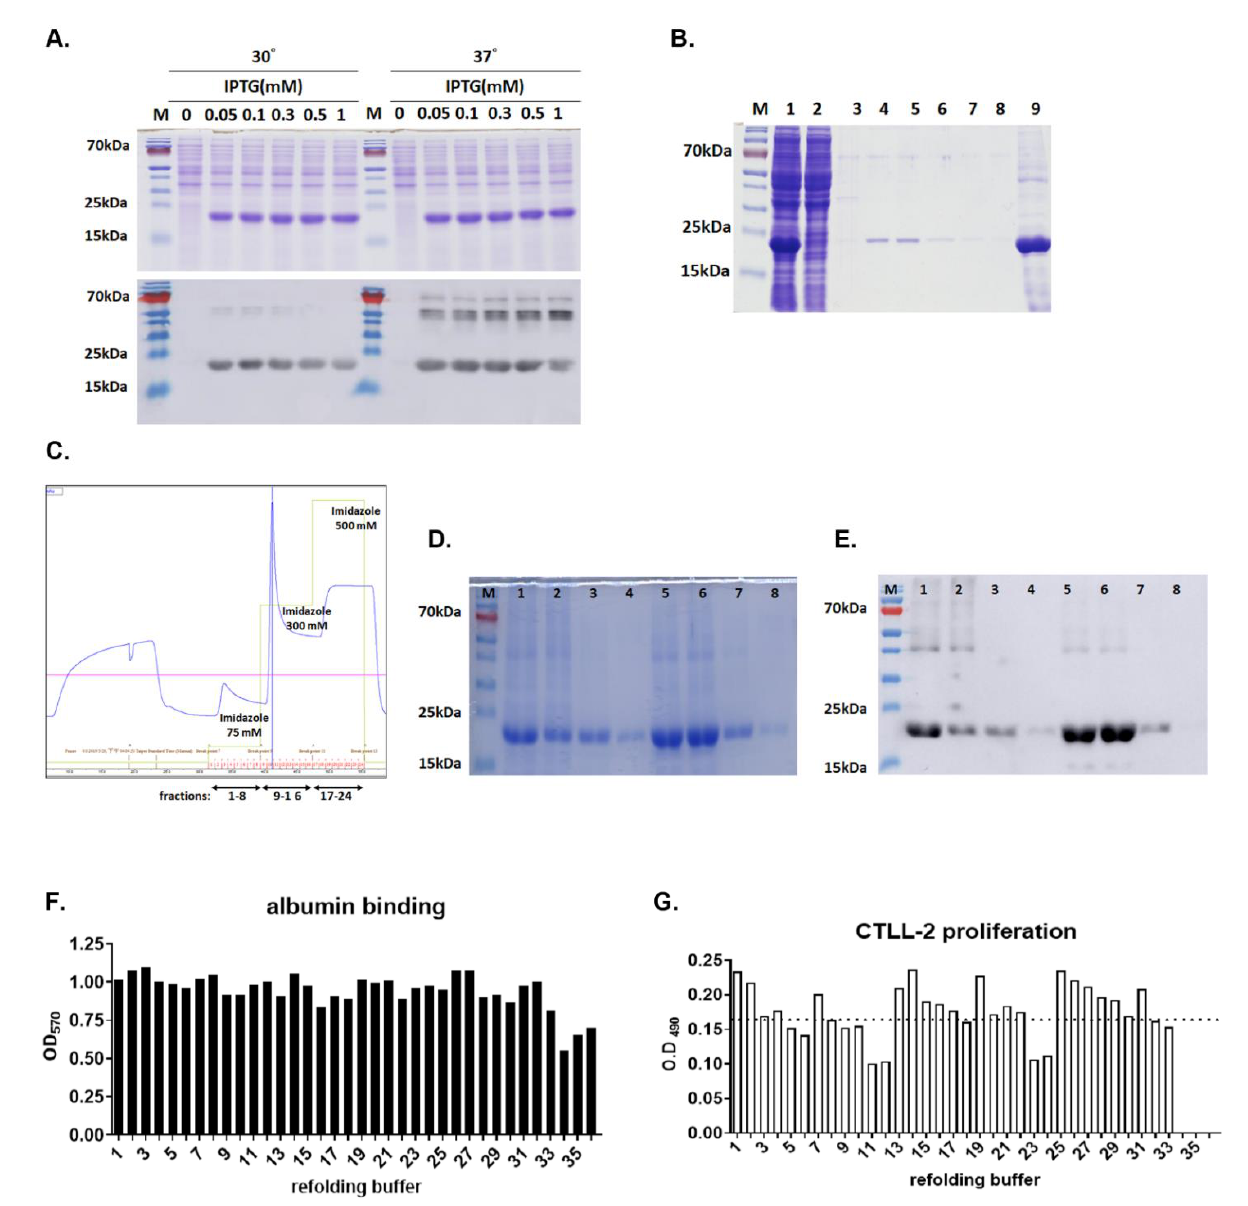
Figure 1. hIL15-ABD expression, refolding and purification. ( A ) SDS-PAGE (upper panel) and Western blot (lower panel) analysis of hIL15-ABD expression induced with increasing concentrations of IPTG, ranging from 0, 0.05, 0.1, 0.3, 0.5, to 1 mM in transformed E. coli , BL21(DE3) at either 30 or 37 °C . ( B ) SDS-PAGE analysis of fractions from transformed E. coli lysates (lane 1); supernatant of the lysates after centrifugation at 10,000 rpm for 20 min (lane 2), supernatant after washing with H 2 O (lane 3); supernatant after washing with 20 mM Tris-HCl (lane 4); supernatant after washing with 50 mM Tris-HCl buffer containing 2 mM EDTA and 0.1% SDS (lane 5); supernatant after washing with 50 mM Tris-HCl, 150 mM NaCl and 2 mM EDTA (lane 6); supernatant after washing with H 2 O (lane 7); supernatant after washing with H 2 O (lane 8); denatured inclusion body in 8 M urea (lane 9). Lane 1 to 8 each are loaded protein equal to 75 µ L and lane 9 equal to 37.5 µ L of culture medium. ( C ) Purification of solubilized inclusion body from E. coli expressing hIL15-ABD through Ni-column. The blue curve indicates the absorption at 280 nm in mAU, whereas the green line represents the concentration of imidazole. ( D ) SDS-PAGE and ( E ) western blot analysis of elution fractions number 3–6 (lane 1–4), 10, 11, and 12 (lane 5–7), and 21 (lane 9). ( F , G ) The purified denatured hIL15-ABD was refolded with buffer matrix listed in Table 1 and resulted L15-ABD is examined for ( F ) human albumin binding and ( G ) stimulation of CTLL-2 proliferation. The dot line indicates the average OD490 values representing the extents of viable CTLL-2 in 96-well plates cultured with refolded